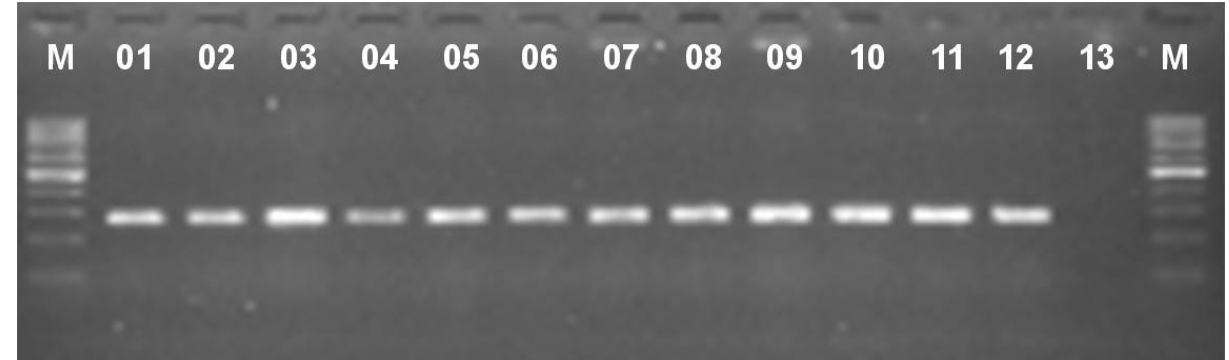
Figure 4. Gel electrophoresis of amplicons after PCR. M, GeneRuler™ 100bp DNA ladder; 01–10, Syrian Cmm iso- lates; 11 and 12, positive controls ( Cmm GSPB 2973 and 390); 13, negative control